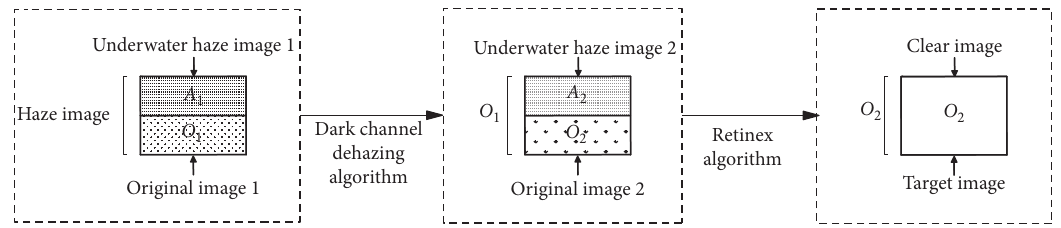
Figure 2: DR image augmentation logic